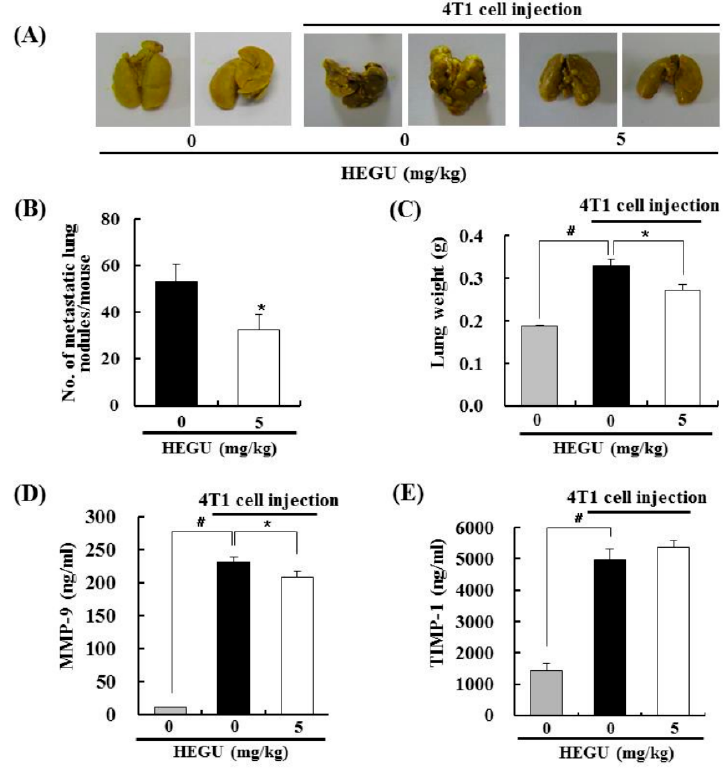
Figure 2. Cont. Figure 2.